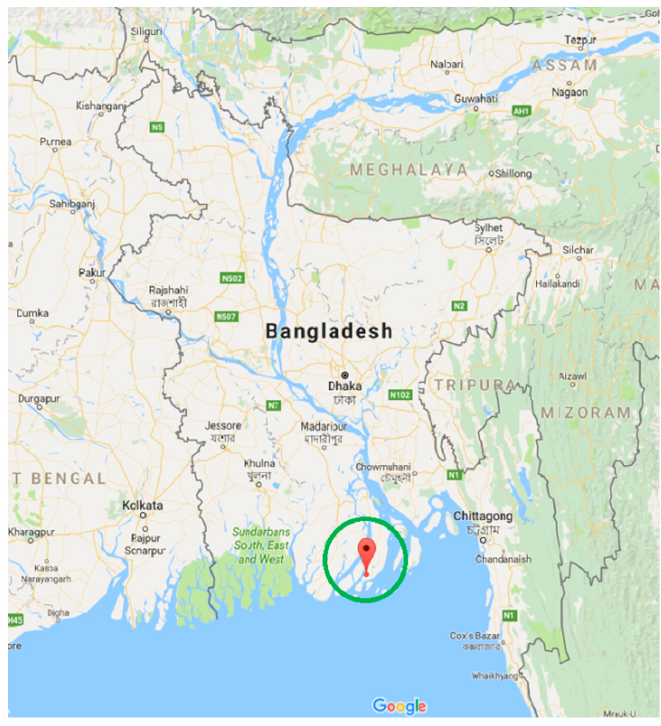
Figure 1. Location on the map of the selected site (map source: www.maps.google.com).